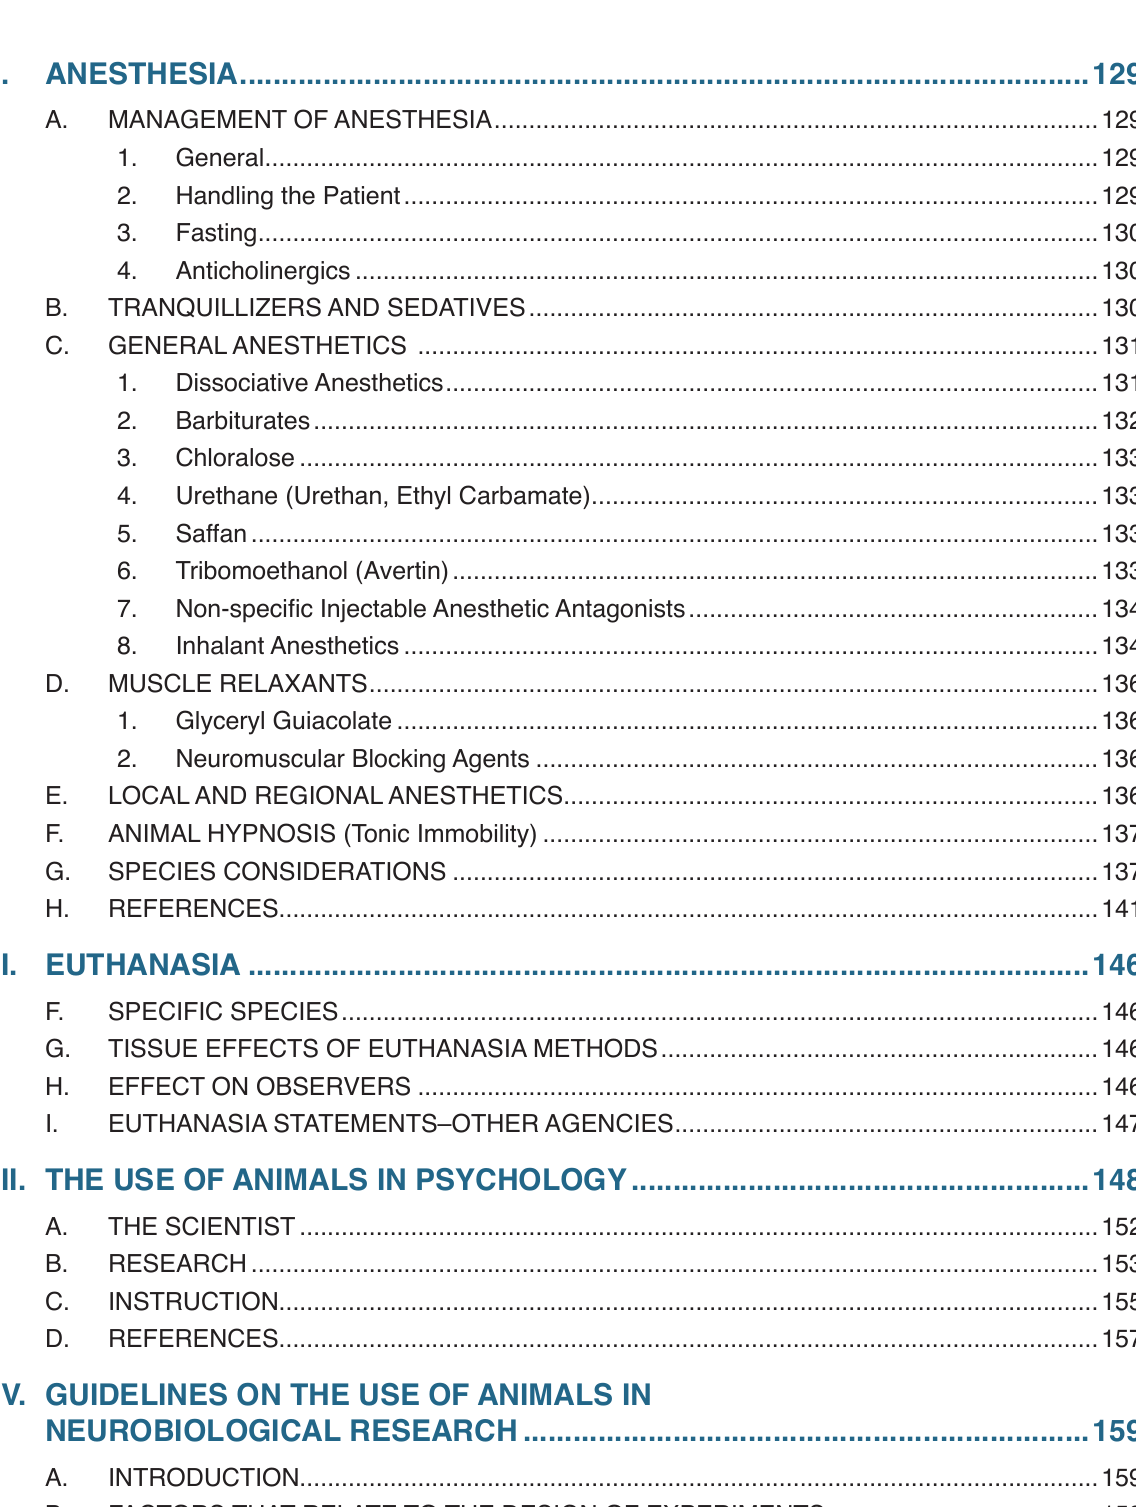
Guide to the Care and Use of Experimental Animals, Volume 1, 2 nd